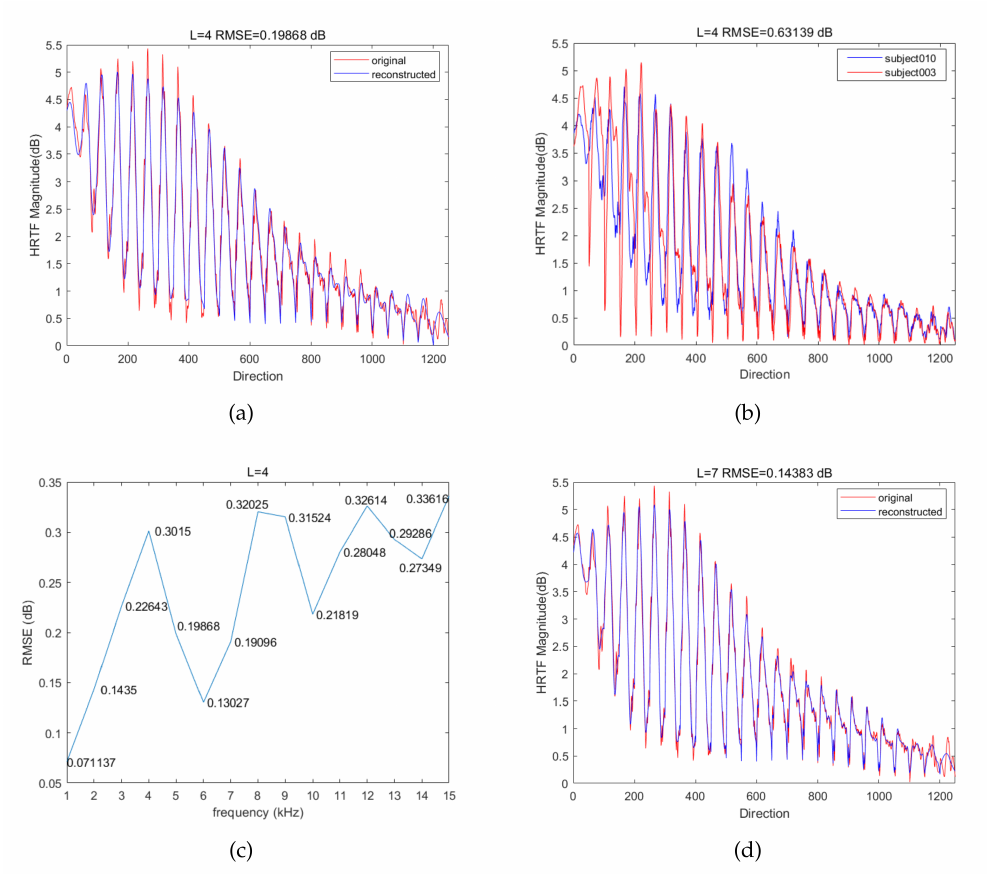
Figure 9. Magnitude comparison: ( a ) Original HRTF and reconstructed HRTF of subject003 at 5 kHz, ( b ) Original HRTF of subject003 and subject010 at 5 kHz, ( c ) RMSE of the original HRTF and reconstructed HRTF at different frequencies, and ( d ) Original HRTF and reconstructed HRTF at L = 7.